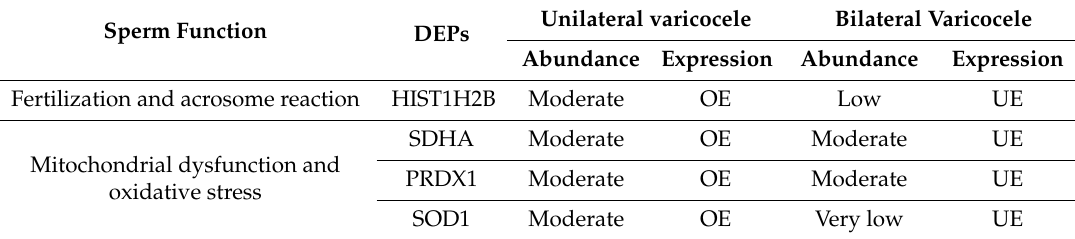
Table 4. Potential acetylated protein biomarkers in the unilateral and bilateral varicocele group.